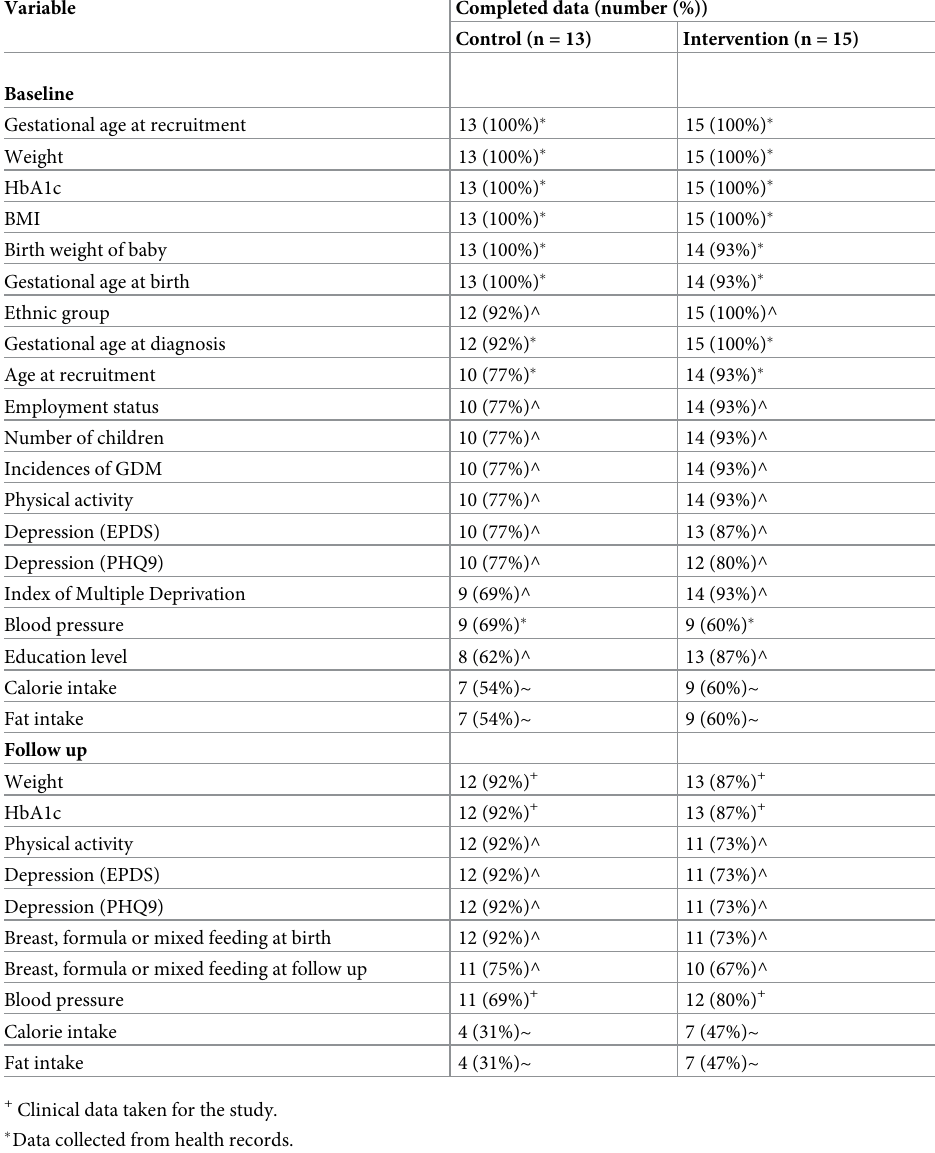
Table 3. Data completion at baseline and follow up. Variable Completed data (number